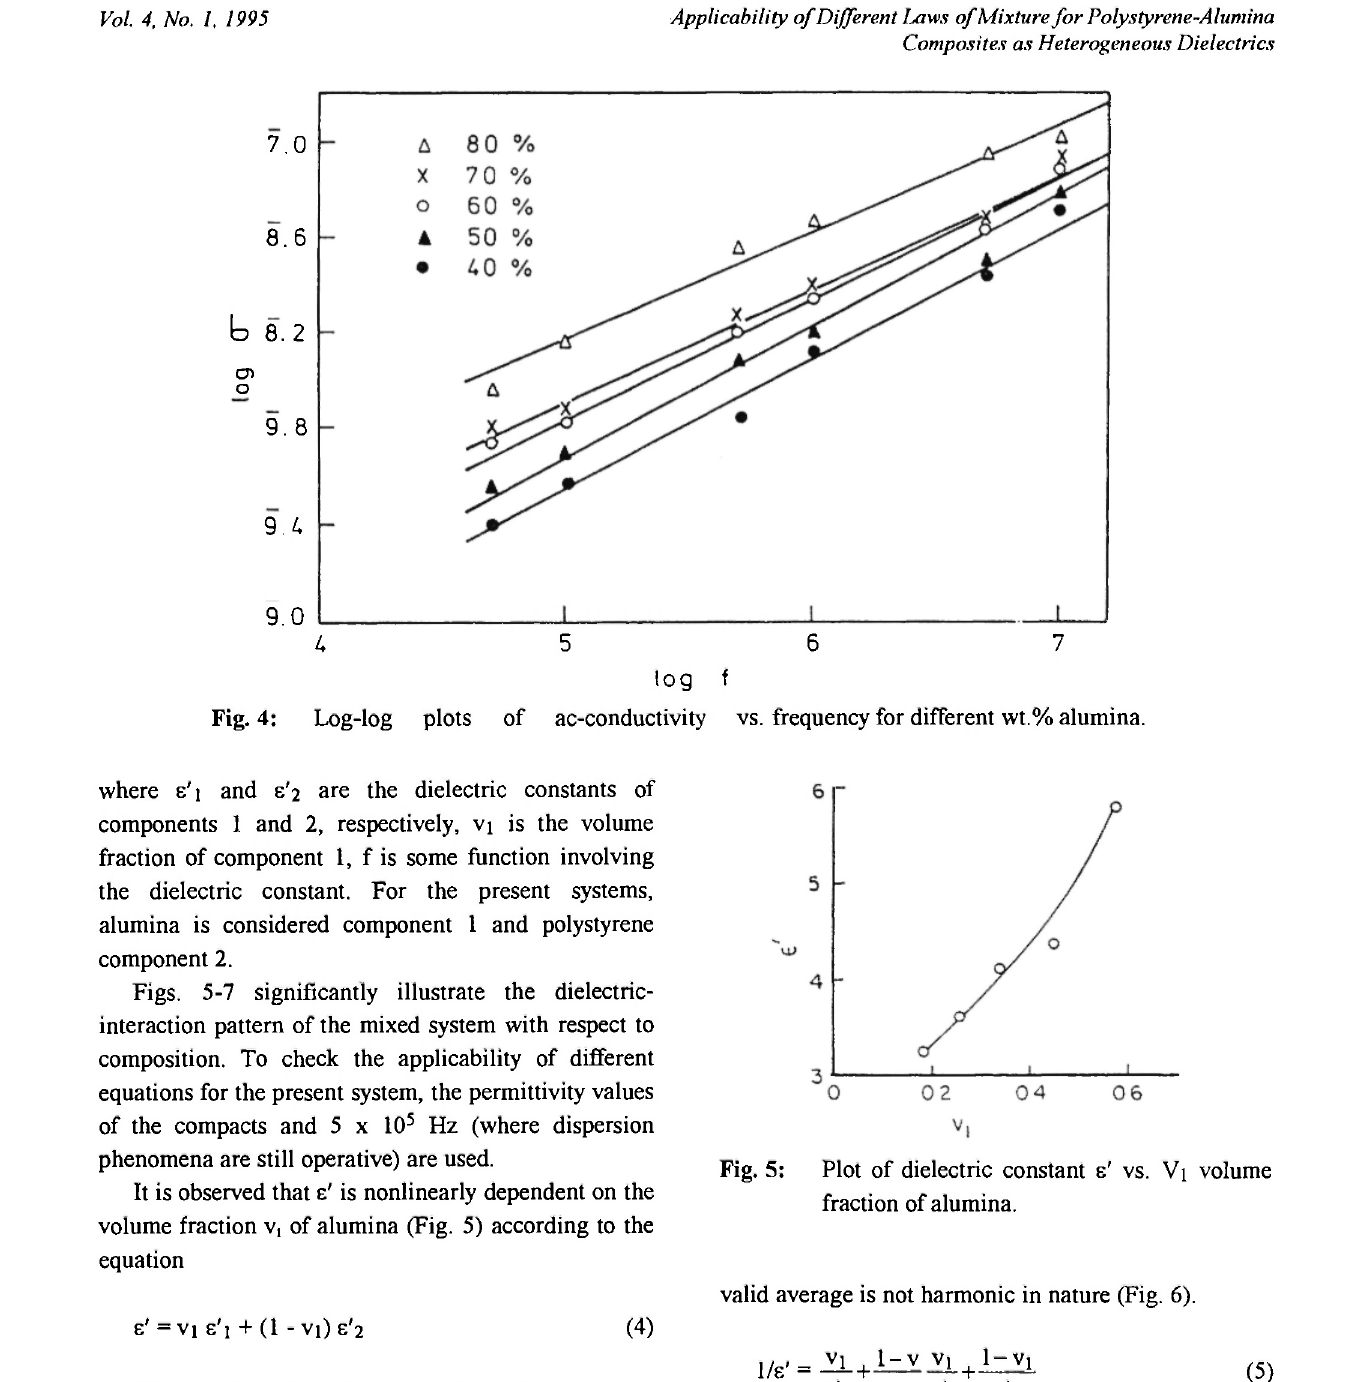
Fig. 5: Plot of dielectric constant ε' vs. Vi volume fraction of